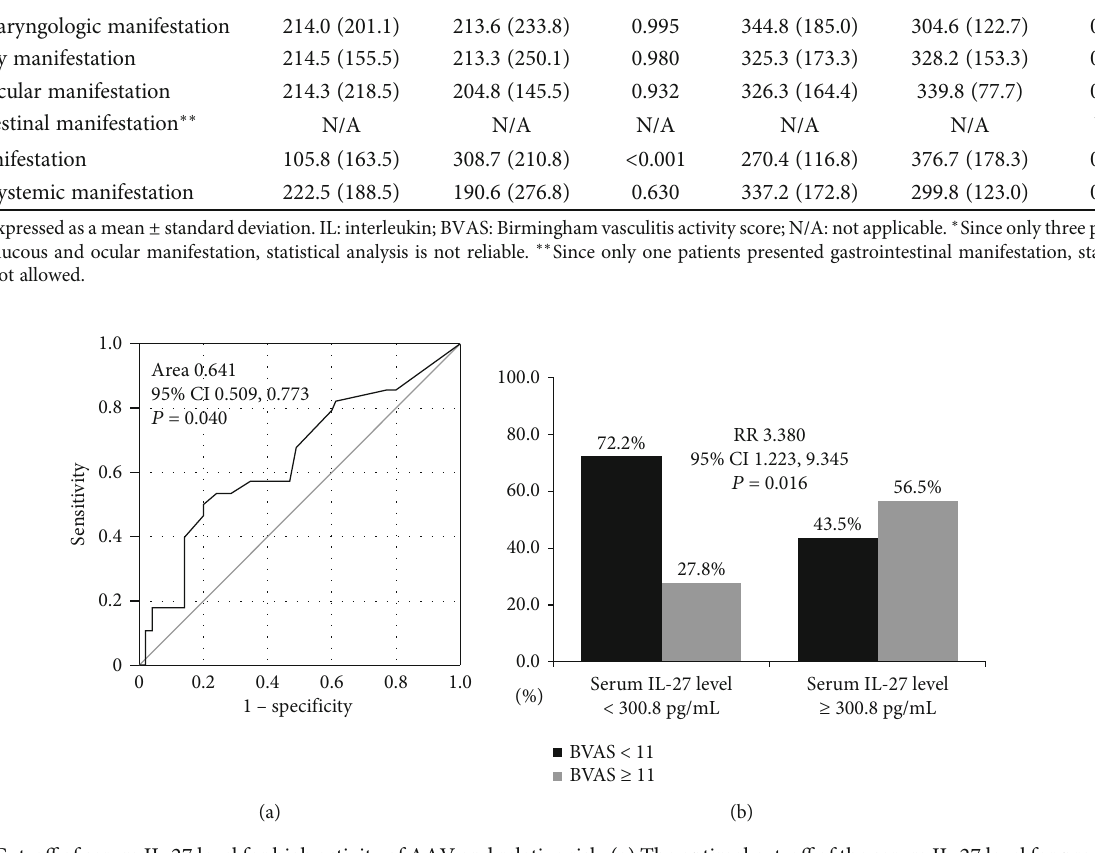
Figure 1: Cut-o ff of serum IL-27 level for high activity of AAV and relative risk. (a) The optimal cut-o ff of the serum IL-27 level for predicting high activity of AAV was set as 300.8pg/mL. (b) AAV patients with serum IL-27 level ≥ 300 : 8 pg/mL had a signi fi cantly higher risk of having high activity than those without. IL: interleukin; ANCA: antineutrophil cytoplasmic antibody; AAV: ANCA-associated vasculitis; RR: relative risk. Table 5: Correlation of serum IL-27 level and serum IL-18 level with the total score of each clinical item of